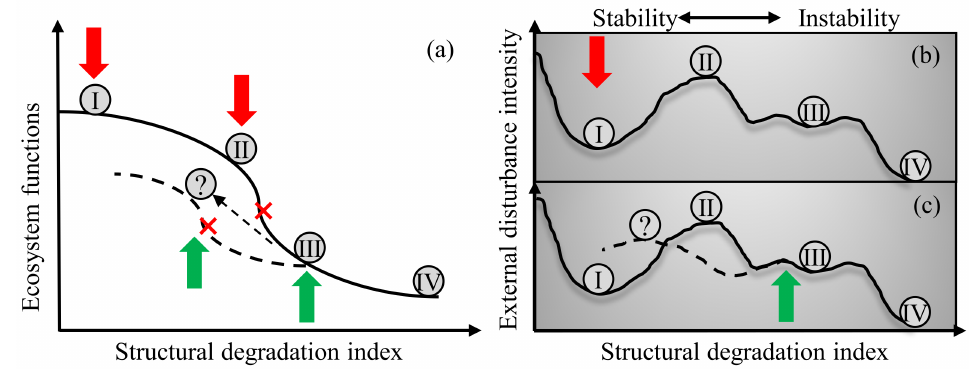
Figure 1. Schematic representation of the stability of different states in a coal mining ecosystem, based on: ( a ) the Structural–Functional State and Transition Model, modified from reference [10]; ( b , c ) the cup ball model. Gray balls with symbols I, II, III and IV represent different states, and ecological stability decreases successively from I to IV. The red arrows represent negative disturbance factors (e.g., coal mining activities), the green arrows represent positive disturbance factors (e.g., vegetable restoration). The gray ball with the (?) symbol represents the state in which it triggers a positive transition (dashed arrow) from an unstable dynamic equilibrium state, when coal mining is removed. The red cross represents the key point of ecological state